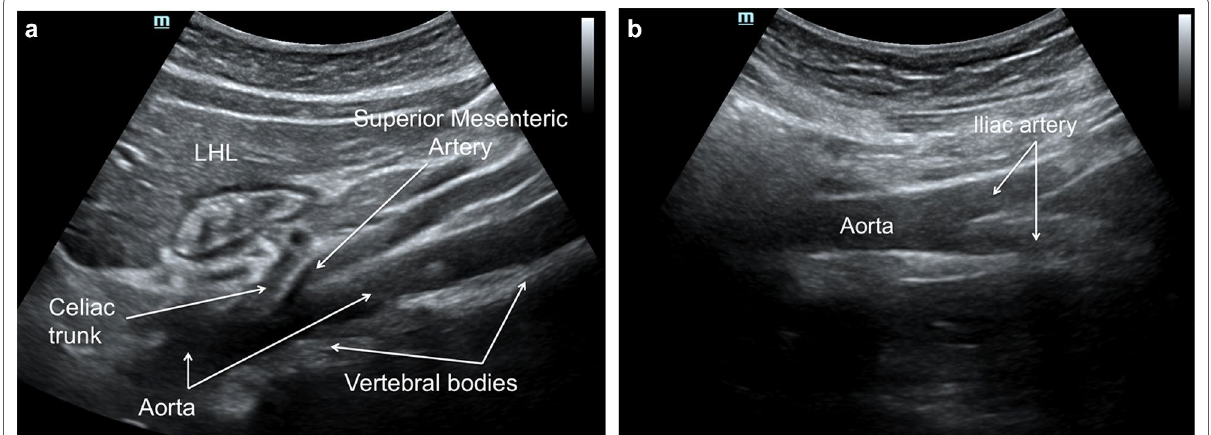
Fig. 1 a Subxiphoid left paramedian longitudinal section with a low-frequency convex transducer, using the left hepatic lobe (LHL) as a window, showing a pulsatile and anechogenic tubular image, supported on the vertebral bodies, corresponding to the aorta. From the ventral face, the celiac trunk emerges first, and then the superior mesenteric artery runs parallel to the aorta shortly after emerging, following the aorta to the aortic bifurcation. b The aorta should be followed distally until the aortic bifurcation